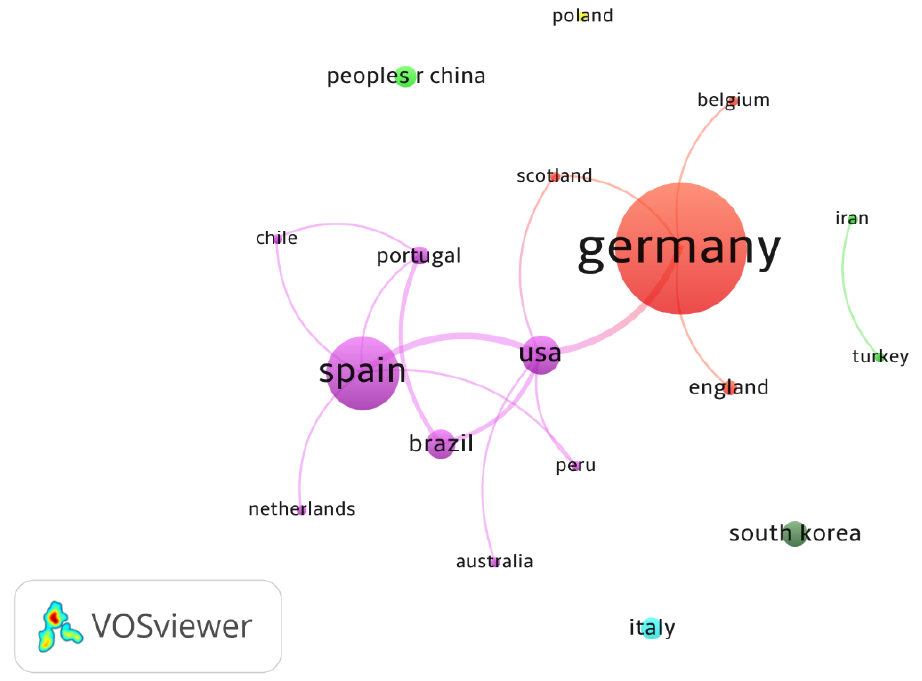
Figure 5. Countries/regions co-authored graphs on WB-EMS.